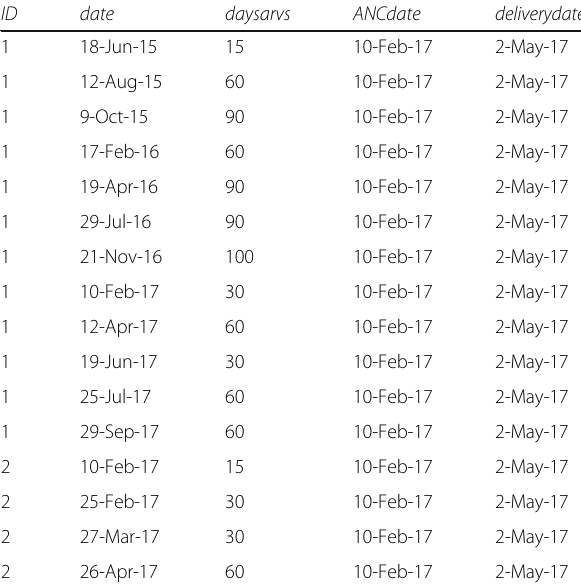
Table 1 Example panel dataset for treatment-experienced and treatment-naïve